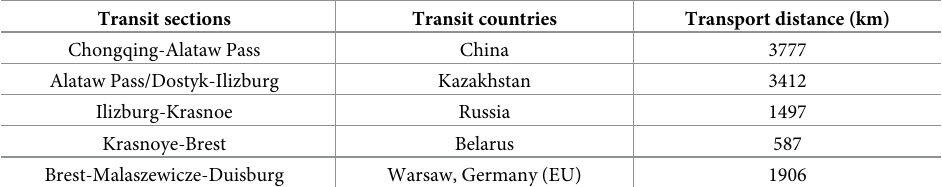
Table 4. The CR Express (Chongqing-Duisburg) sections of the transport